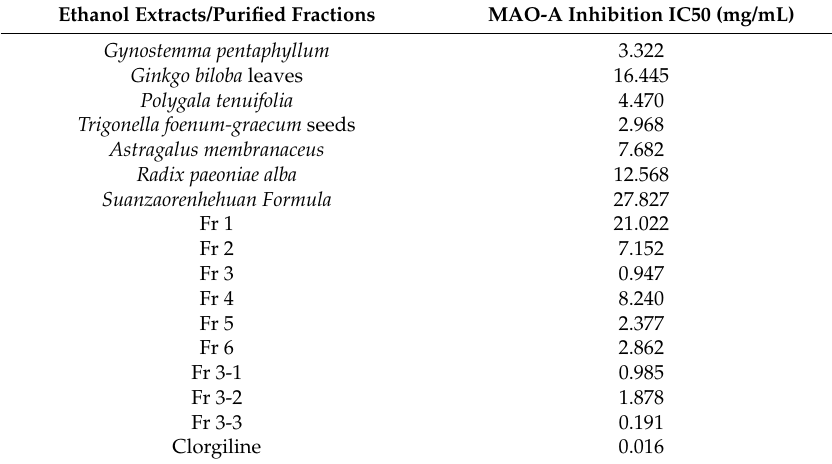
Figure 1. MAO-A inhibition rates of different concentration of samples. ( A ) Plant ethanol extracts. ( B ) Primary fractions by HP-20 macroporous resin from the ethanol extract of Trigonella foenum-graecum seeds. ( C ) Secondary fractions by Sephadex LH-20 from Fr 3. Table 1. IC 50 values of MAO-A inhibition rates.